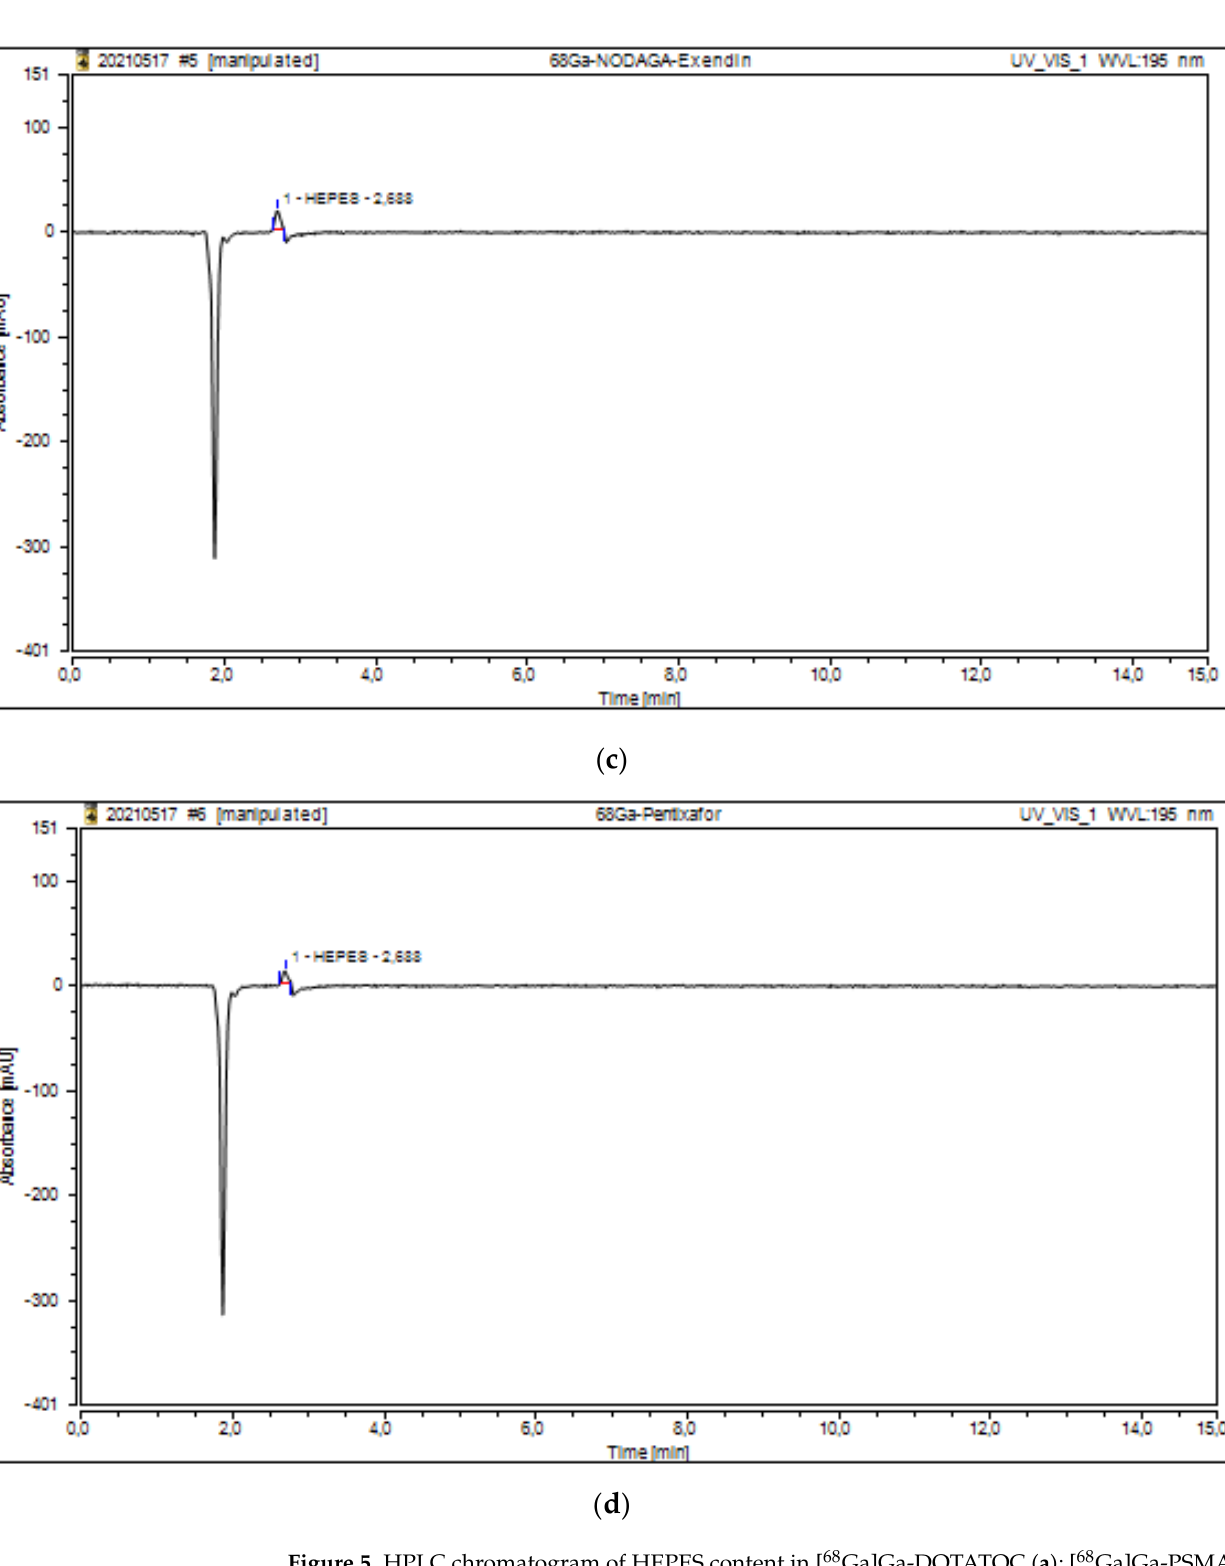
Figure 5. HPLC chromatogram of HEPES content in [ 68 Ga]Ga-DOTATOC ( a ); [ 68 Ga]Ga-PSMA ( b ); [ 68 Ga]Ga-NODAGA-Exendin-4 ( c ); and [ 68 Ga]Ga-Pentixafor ( d ). To ensure that the HEPES peak was not altered by the peak of the radiopharmaceu- tical, an injection of the cold radiopharmaceutical without HEPES was performed (Figure 6).